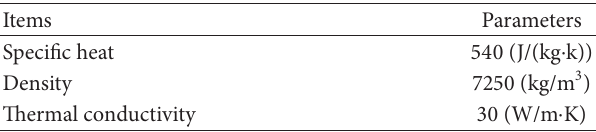
Table 2: Physical parameters of steel